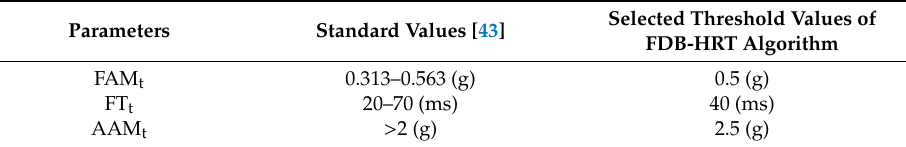
Table 1. Standard and adopted threshold values of FDB-HRT